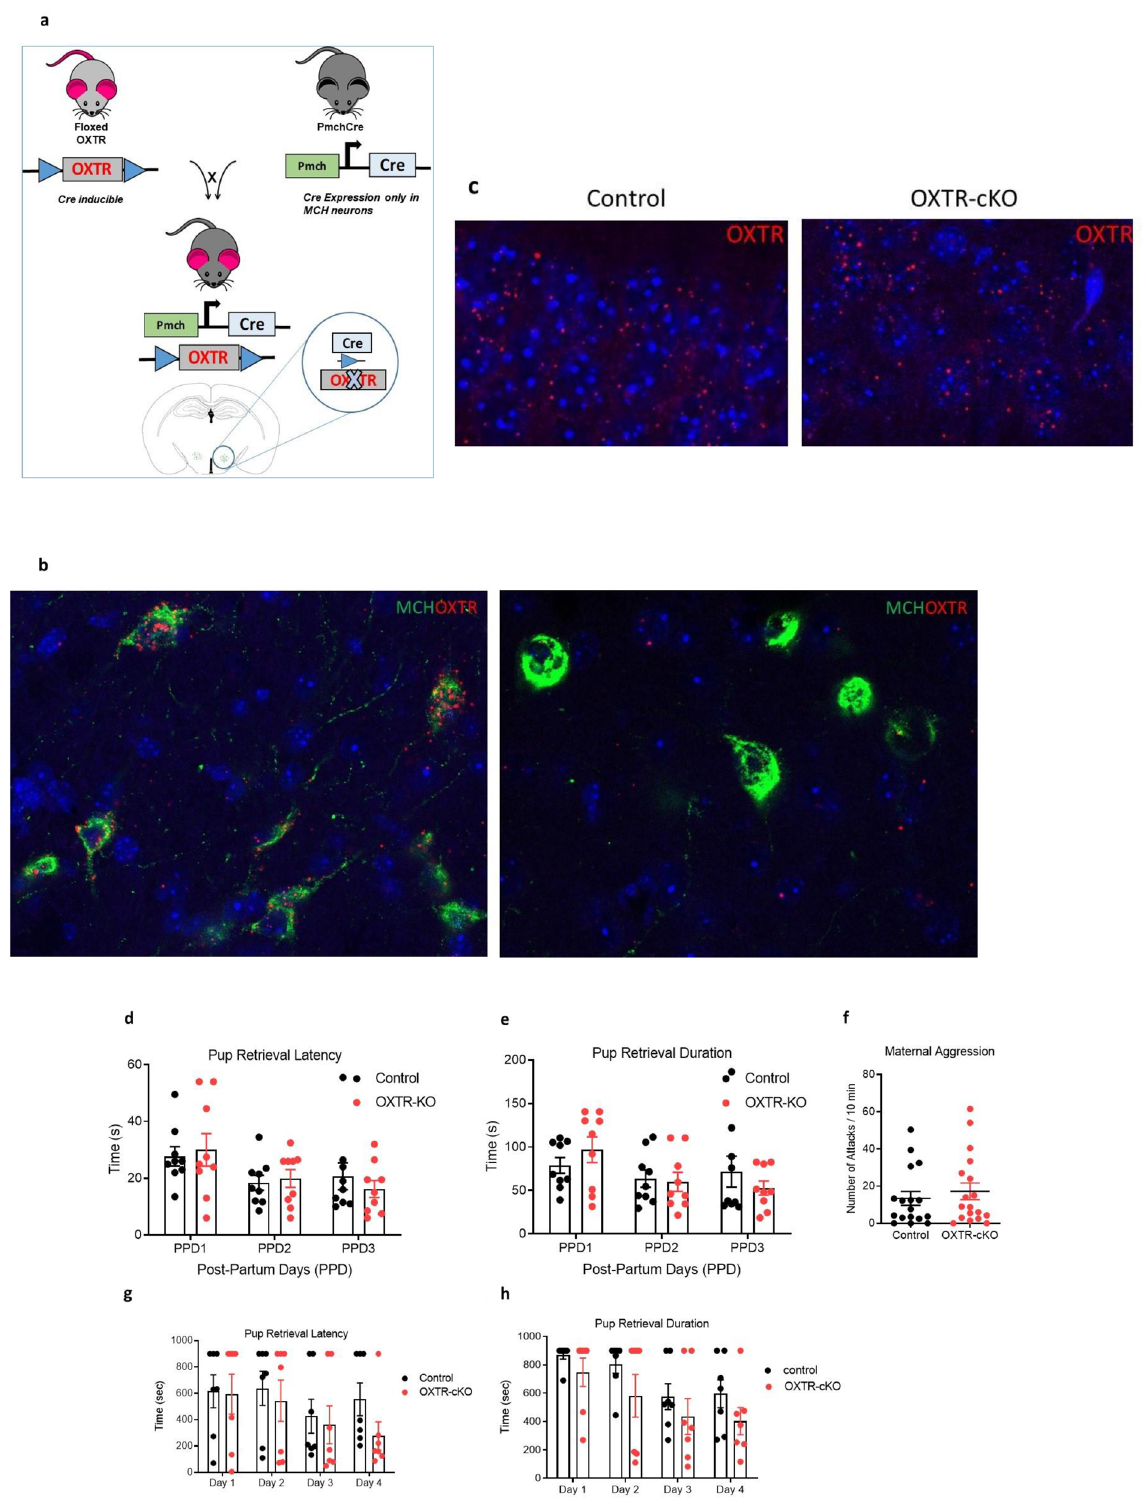
Figure 2. Deletion of the OXTR from MCH neurons does not affect maternal behaviors in virgin or postpartum mothers. ( a ) Schematic representation of the generation of MCHCre OXTRfl/fl conditional knockouts (Brain Image Credit: The Mouse Brain Atlas 36 ). ( b ) Representative images of FISH and immunostaining showing the conditional deletion of OXTR mRNA in the MCH neurons of mouse of control and OXTR-cKO mice (counterstained with DAPI, blue). ( c ) FISH staining of the CA1 of the hippocampus showing the intact expression of OXTR in OXTR-cKO. ( e , f ) pups’ retrieval in postpartum mice: ( d ) latency to retrieve the first pup, ( e ) duration to retrieve three pups (n control = 9, n OXTR-cKO = 9, P > 0.05, two-way ANOVA). ( g ) maternal aggression by postpartum mice (n control = 17, n OXTR-cKO = 18, P > 0.05, unpaired t test). ( h , i ) pups’ retrieval by sexually naïve female mice: ( g ) latency to retrieve the first pup, ( h ) duration to retrieve three pups (n control = 7, n OXTR-cKO = 7, P > 0.05, two-way